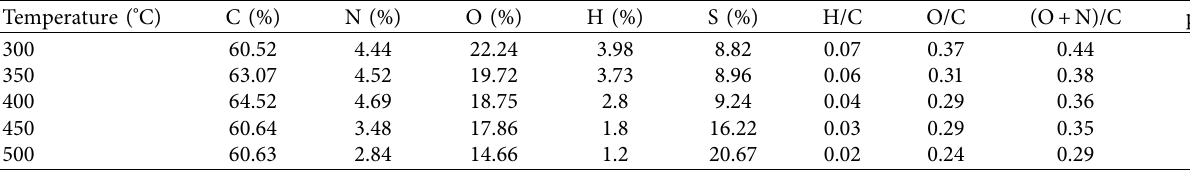
Table 1: Biochar’s elemental profile at various pyrolysis temperatures.